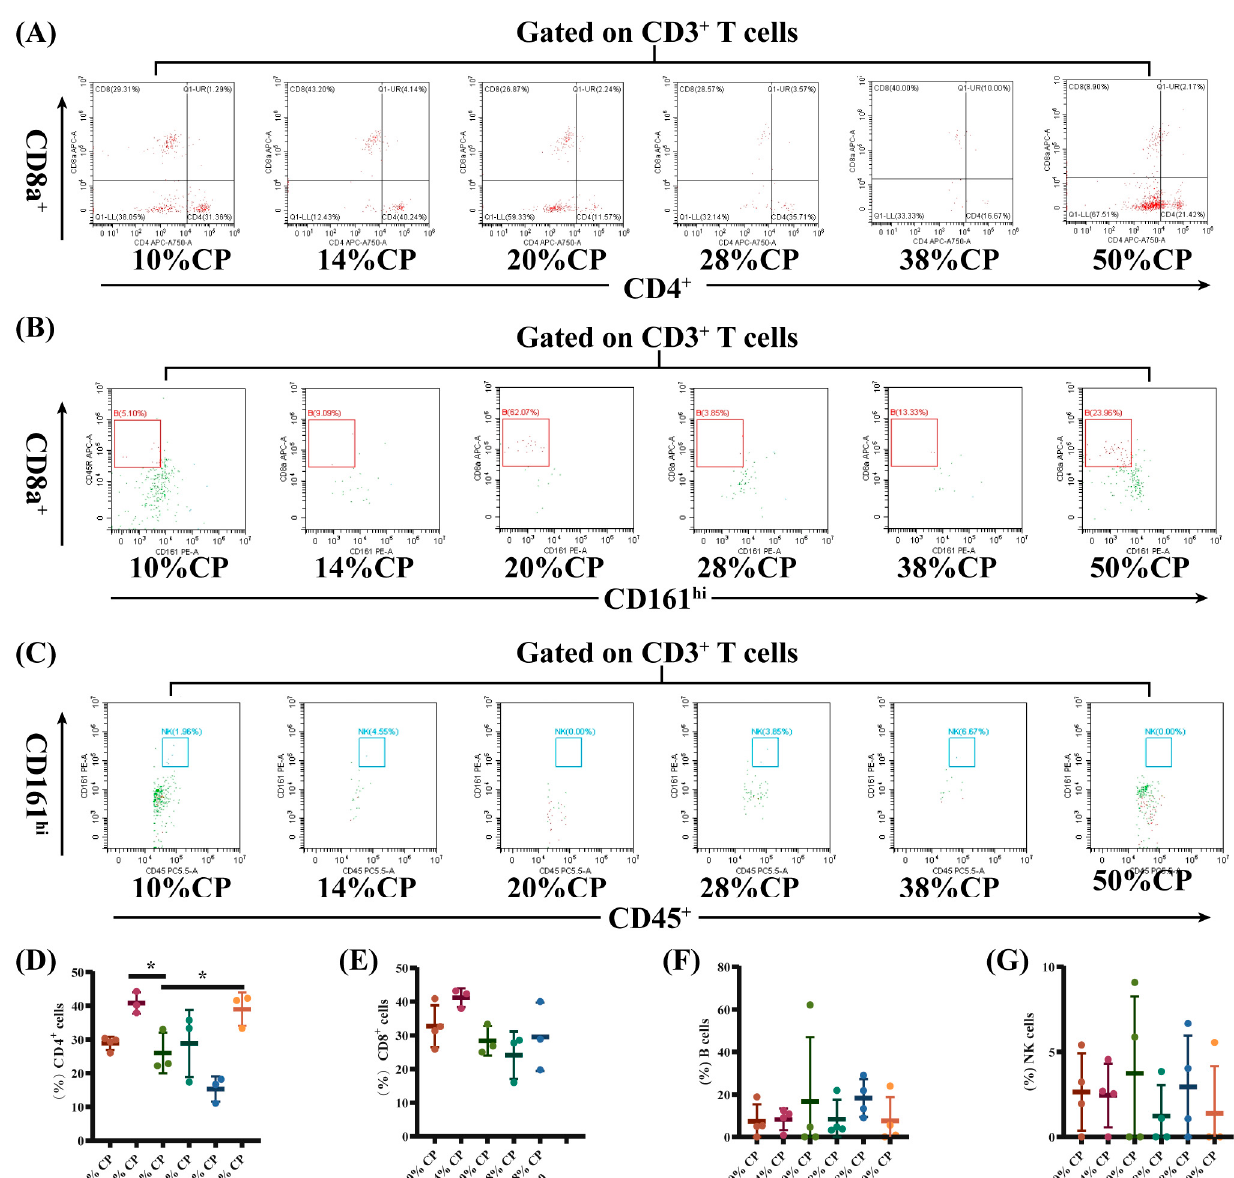
Figure 4. Effects of feeding diets with different protein concentrations for 6 weeks on the lymphocyte subsets in the colon tissue of SD rats ( n = 3–4). The colon tissue lymphocyte subsets were stained with appropriate antibodies and isotype controls and initially gated on CD45 + and CD3 + T cells. Dot plots depicting the approach to gating on ( A ) CD4 + and CD8 + T cells; ( B ) B cells; and ( C ) NK cells in rats fed of 10%, 14%, 20% (control), 28%, 38%, and 50% crude protein diets. Percentages of circulating ( D ) CD4 + T cells; ( E ) CD8 + T cells; ( F ) B cells; and ( G ) NK cells in rats fed the 10%, 14%, 20% (control), 28%, 38%, and 50% CP crude protein diets. * p < 0.05, compared with the 20% crude protein diet.